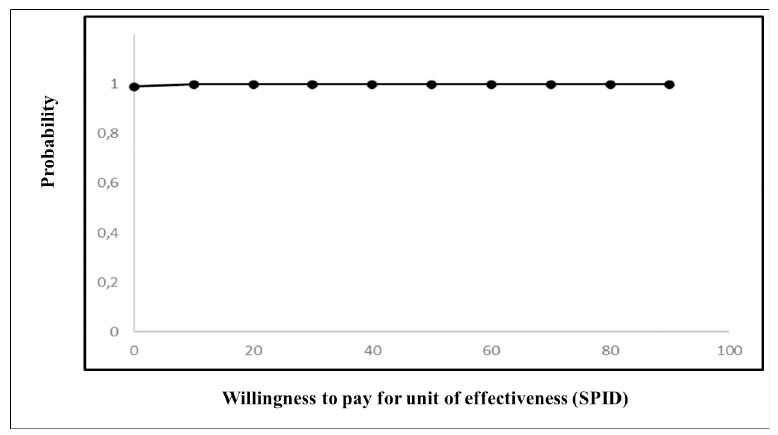
Fig 2. Cost-effectiveness acceptability